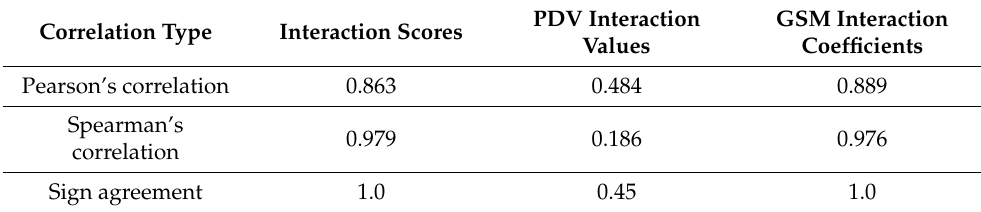
Table 3. Correlations of the computed (population-level) interaction scores, PDV interaction values and the GSM interaction coefficients with the true interaction coefficients in the underlying rela- tionship for Simulation Data #1. The correlations are based on the 20 variable pairs with nonzero coefficients